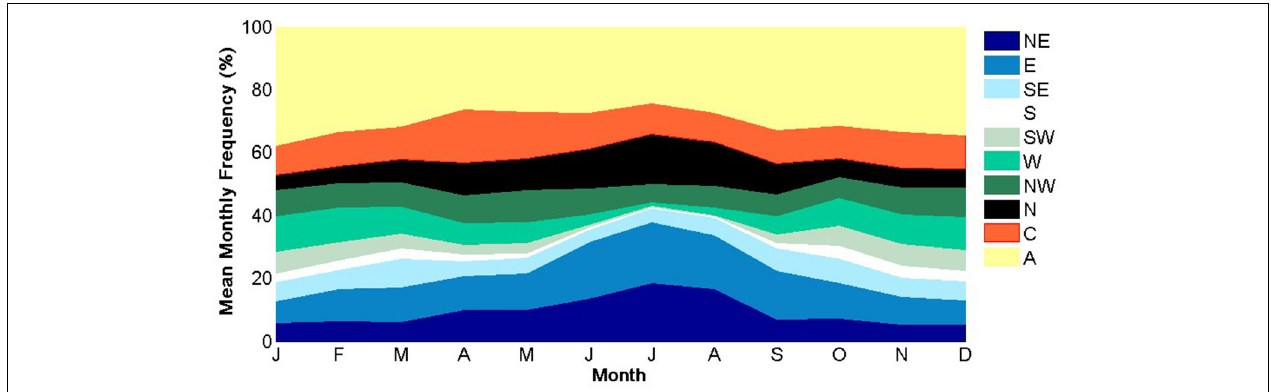
FIGURE 2 | Mean monthly frequency (%) for the 10 CWT during the 1950–2012 period. The circulation patterns are labeled as follows: A, Anticyclonic; C, Cyclonic; N, North; S, South; W, West; E, East; NW, Northwest; NE, Northeast; SW, Southwest and SE, Southeast.